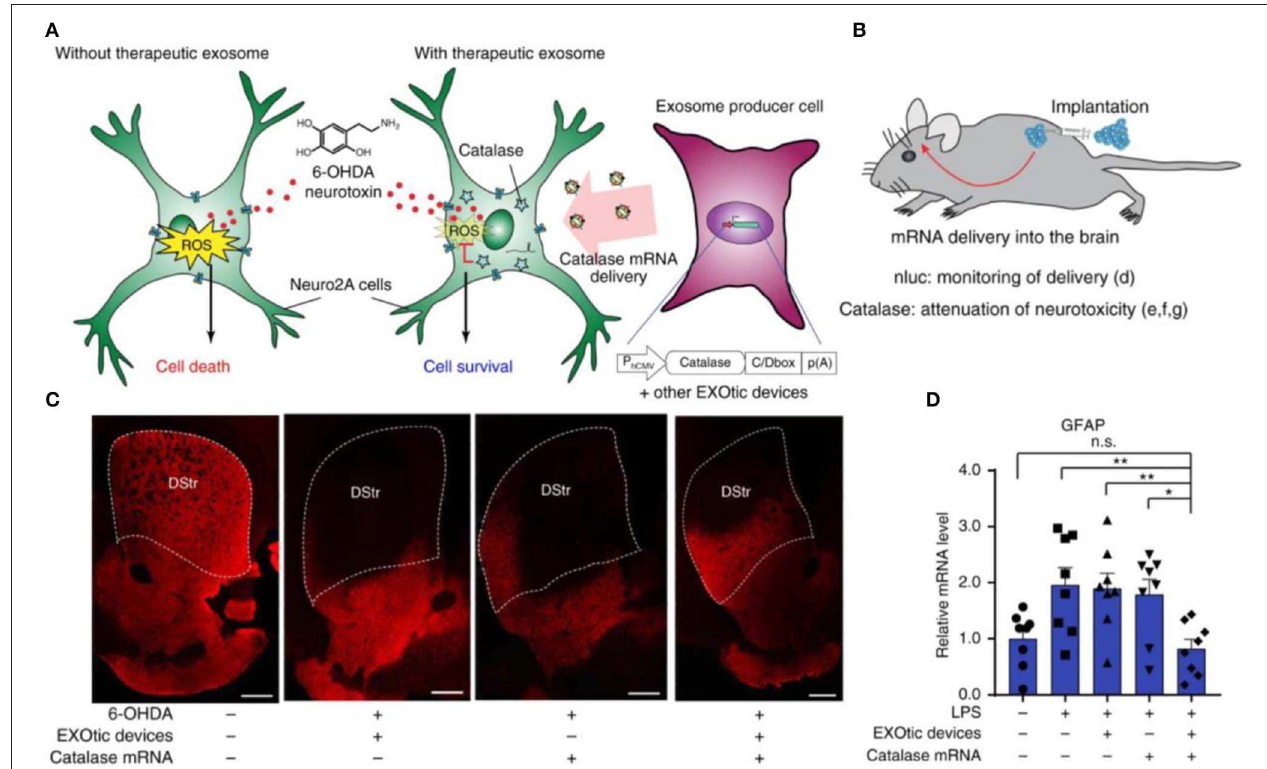
FIGURE 4 | Applications of the engineered exosomes loaded with CAT mRNA in Parkinson’s disease. (A) Schematic illustration of protection against neurotoxicity in an in vitro experimental model of Parkinson’s disease by CAT mRNA delivery. (B) Engineered exosome producer cells were subcutaneously implanted with Matrigel in living mice. (C) Immunostaining result of tyrosine hydroxylase (TH)-positive neurons. Scale bars, 500 µ m. (D) Attenuation of neuroinflammation caused by systemic LPS injection with catalase mRNA delivery in vivo . Reproduced with permission from Kojima et al. (2018). * p < 0.05, ** p < 0.01; n.s., no